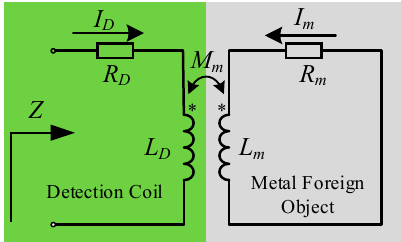
Figure 2. Mutual inductance coupling model between metal foreign object and detection coil.